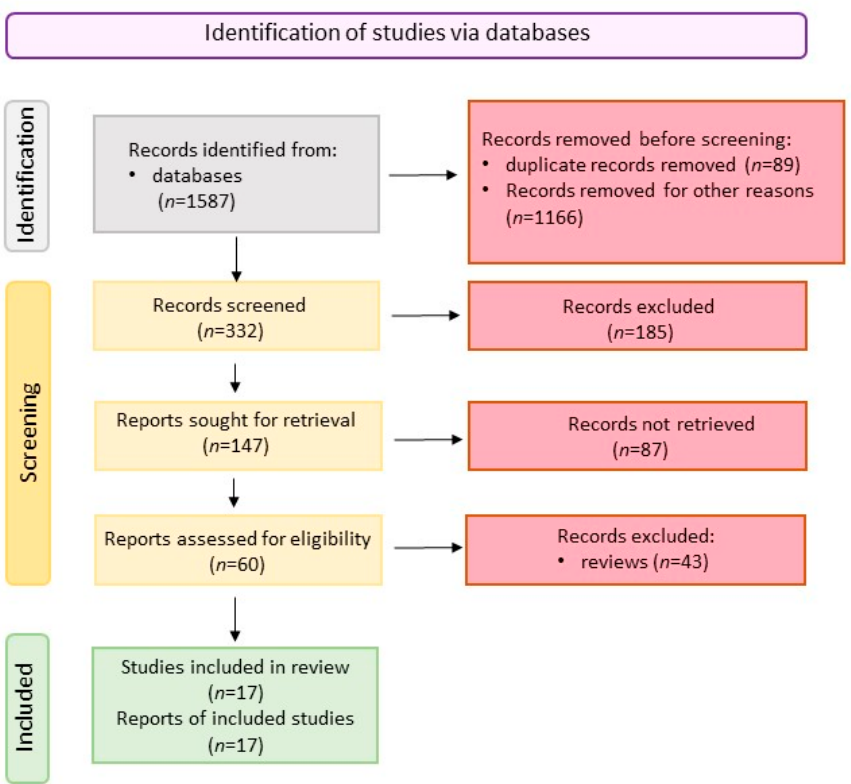
Figure 2. Scheme of literature searching (created with BioRender.com, accessed on 25 July 2022).